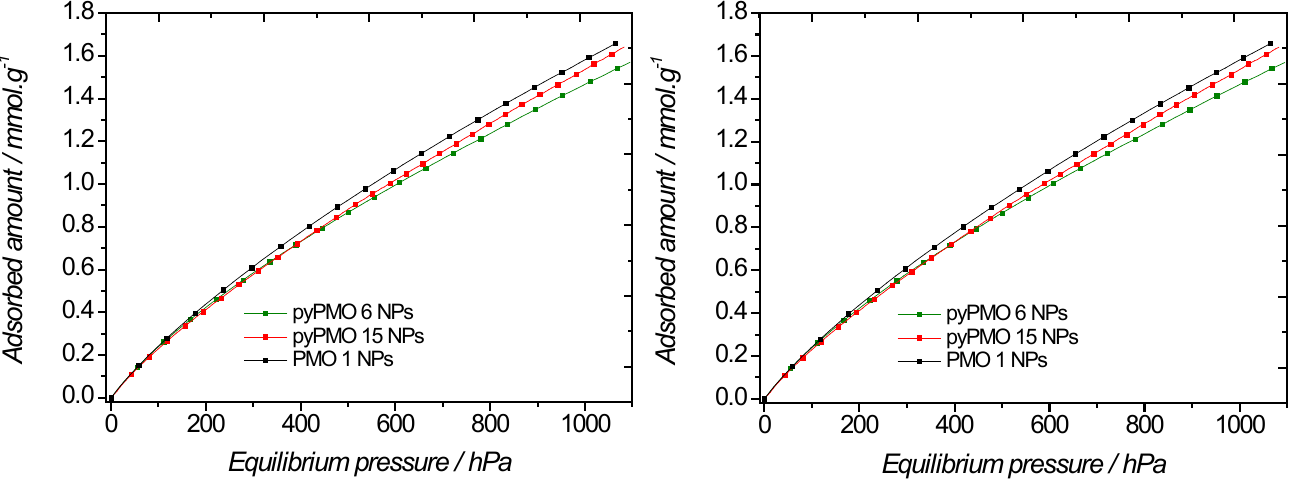
Figure 6. Evolution of the CO 2 adsorption of BTEE/pyPMO NPs with different pyridine molar fractions versus absolute pressure, at 298 K ( left ) and 273 K ( right ). Table 2. CO 2 adsorption capacity (expressed as mmol·g −1 ) at 10 5 Pa for the BTEE/pyridine PMO NPs.